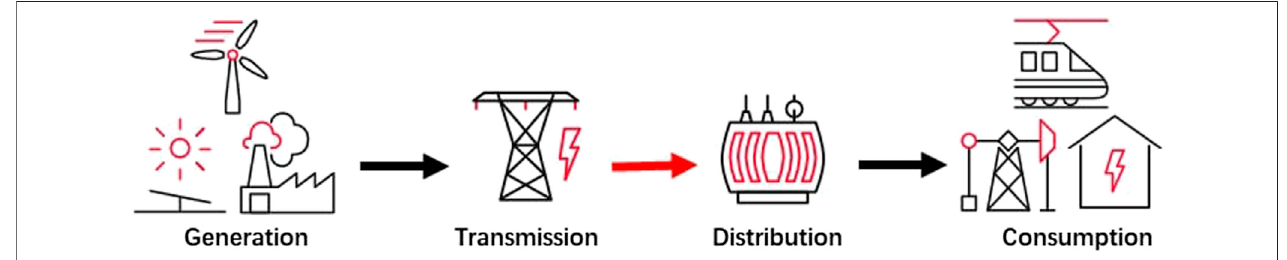
FIGURE 1 | Schematic diagram of the traditional power